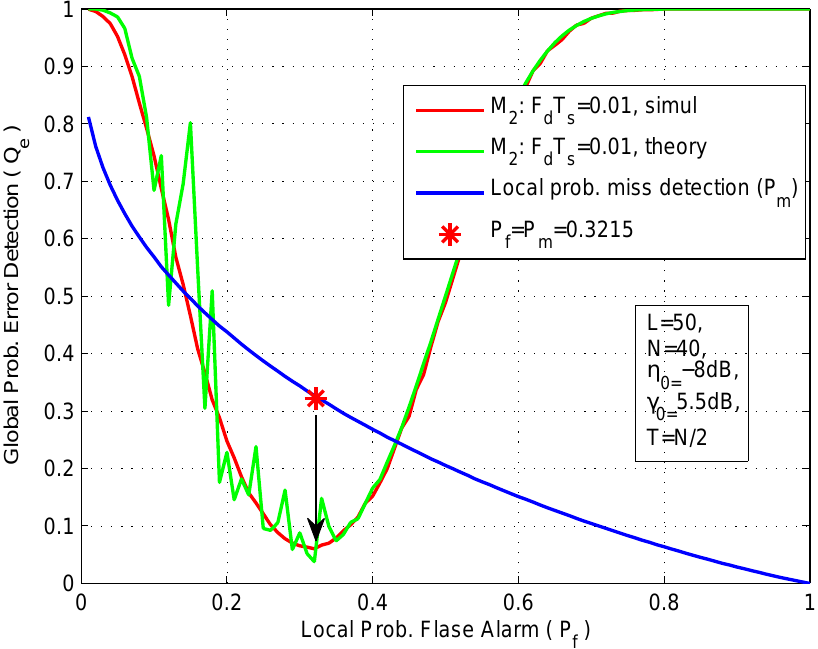
Figure 9. The global probability of error detection as a function of local probability of flase